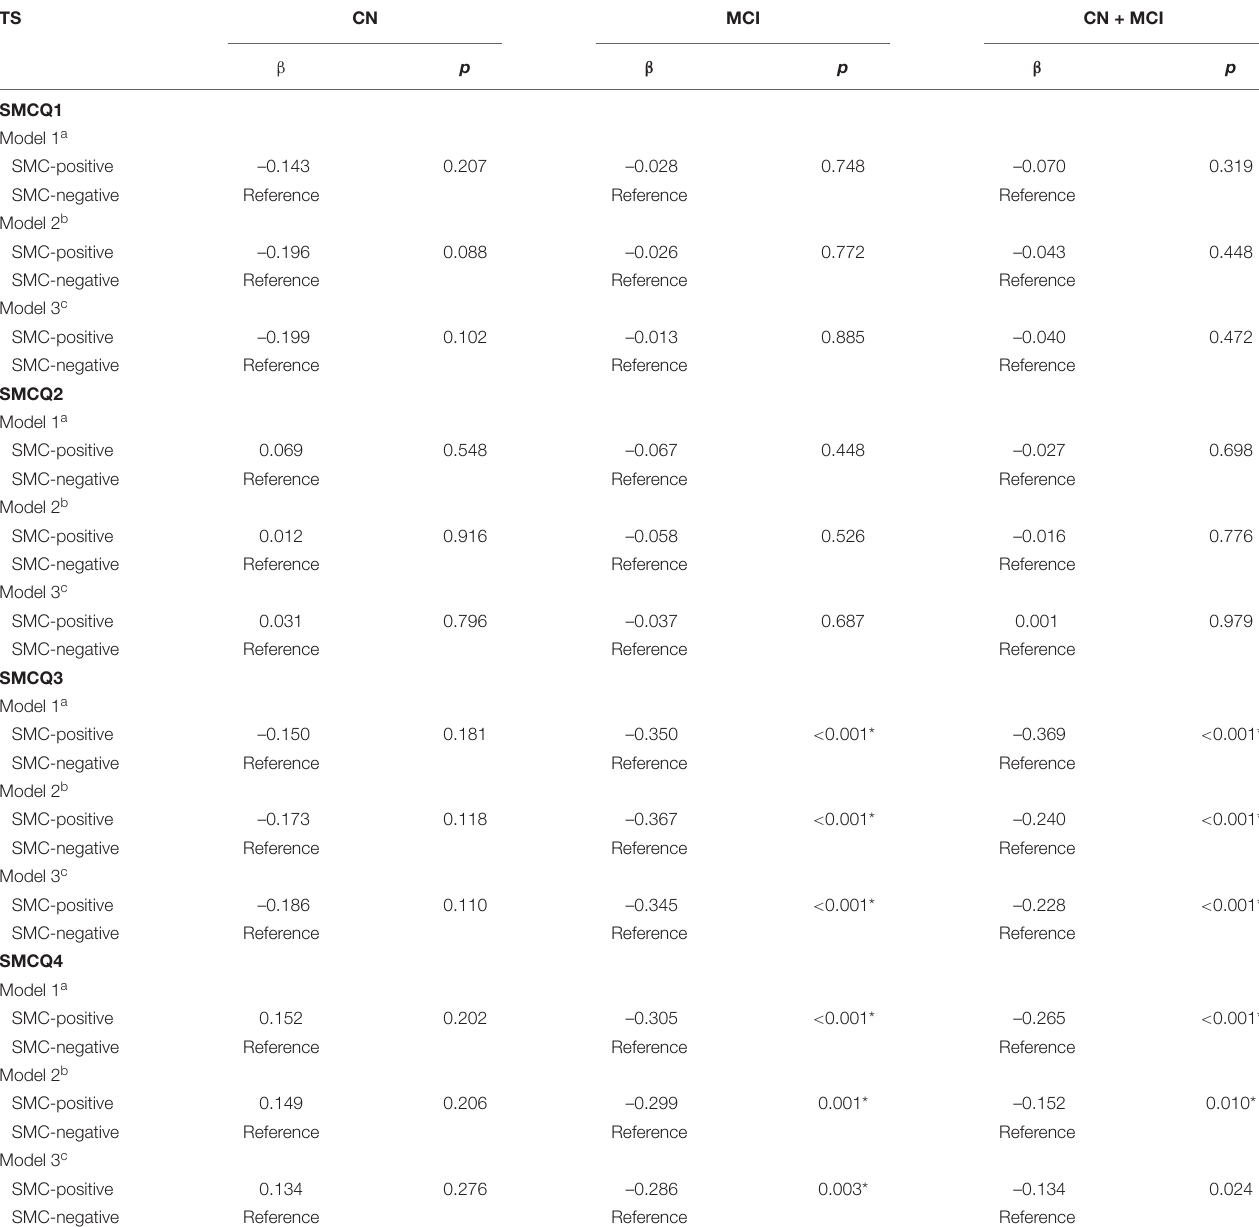
TABLE 2 | Results of multiple linear regression analyses for the associations of SMC with objective cognitive performance in CN, MCI, and non-demented older adults.